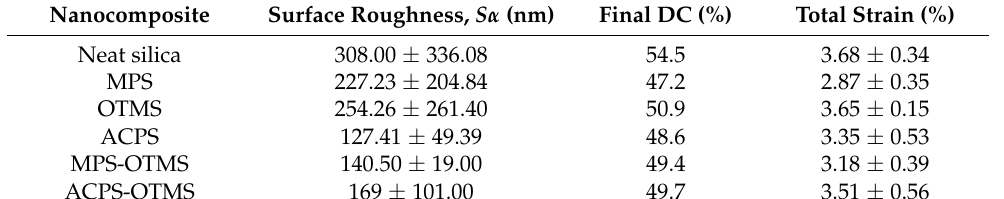
Table 2. Surface roughness (median values ± interquartile range, IQR), curing kinetics, and polymer- ization shrinkage data (median values ± IQR) calculated for the synthesized dental nanocomposite resins.